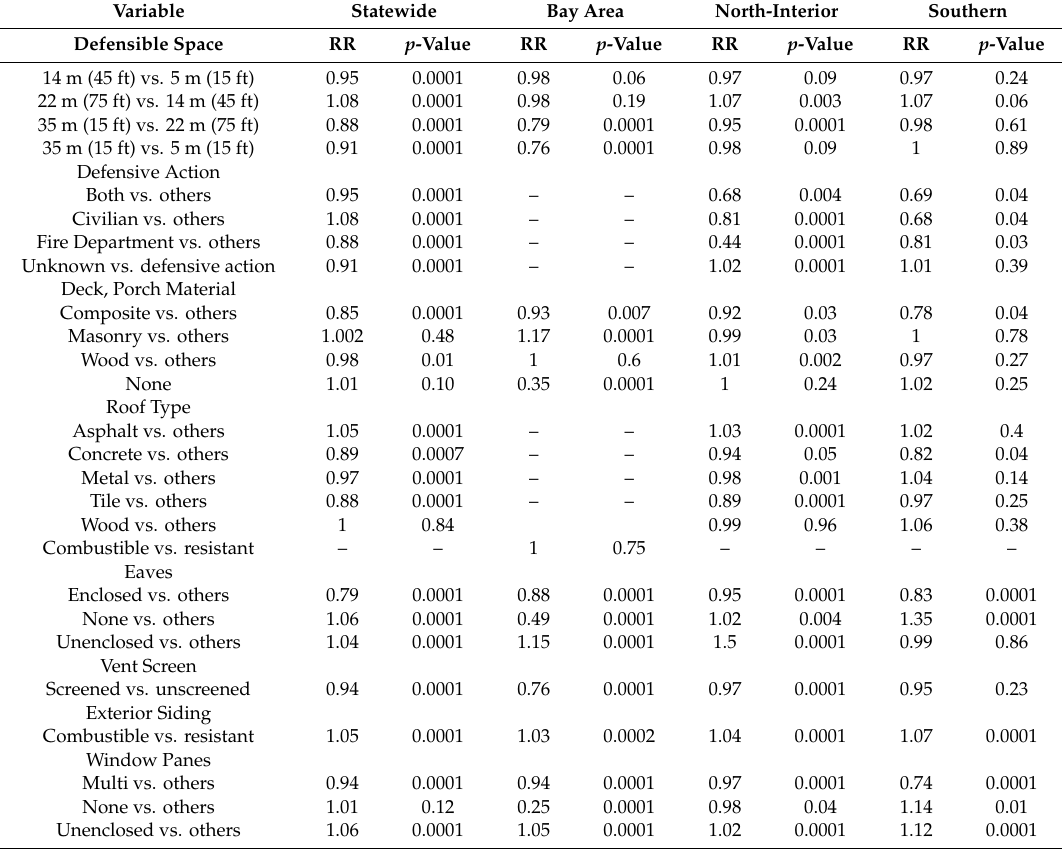
Table 2. Relative risk (RR) among building inspection variables statewide and for three California regions. A relative risk of 1 indicates no di ff erence between classes; > 1 means the relative risk of destruction is higher in the first category listed; < 1 means the relative risk of destruction is lower than in the other classes. Dashes indicate where no data were available for certain